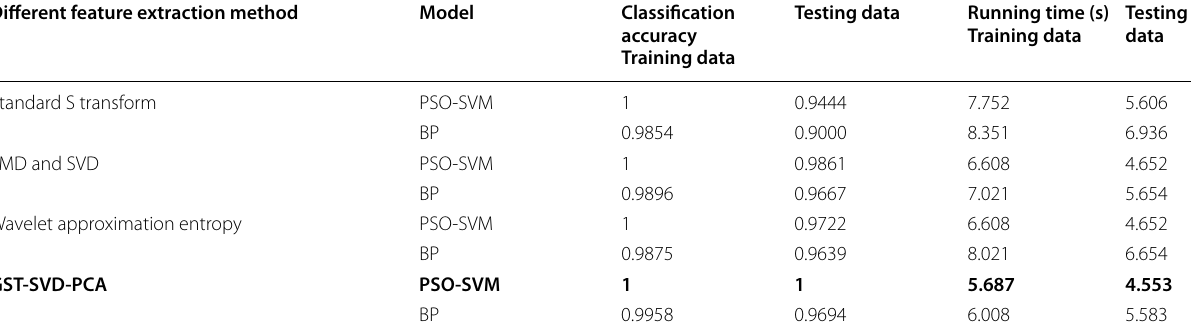
Bold values indicate the results obtained using the proposed method